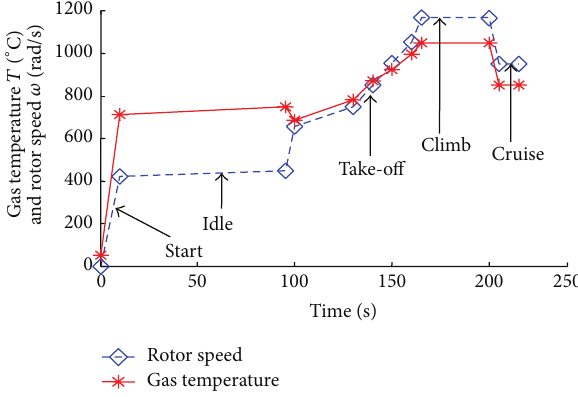
Figure 2: Load spectrums for